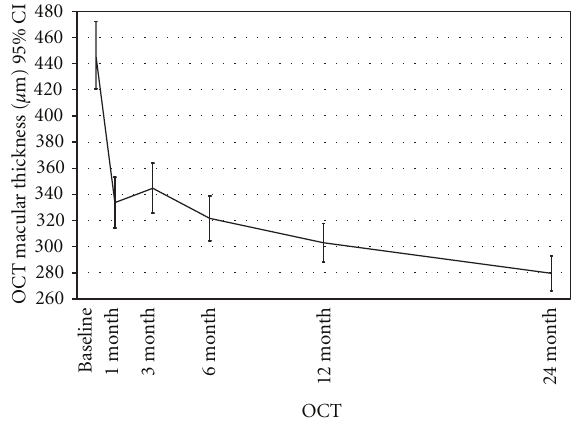
Figure 2: Changes in macular thickness with optical coherence tomography (OCT) during followup after intravitreal bevacizumab. The foveal thickness improved after 1 month, mean 1-mm central macular thickness (CMT) measurement decreased from 446 . 4 µ m